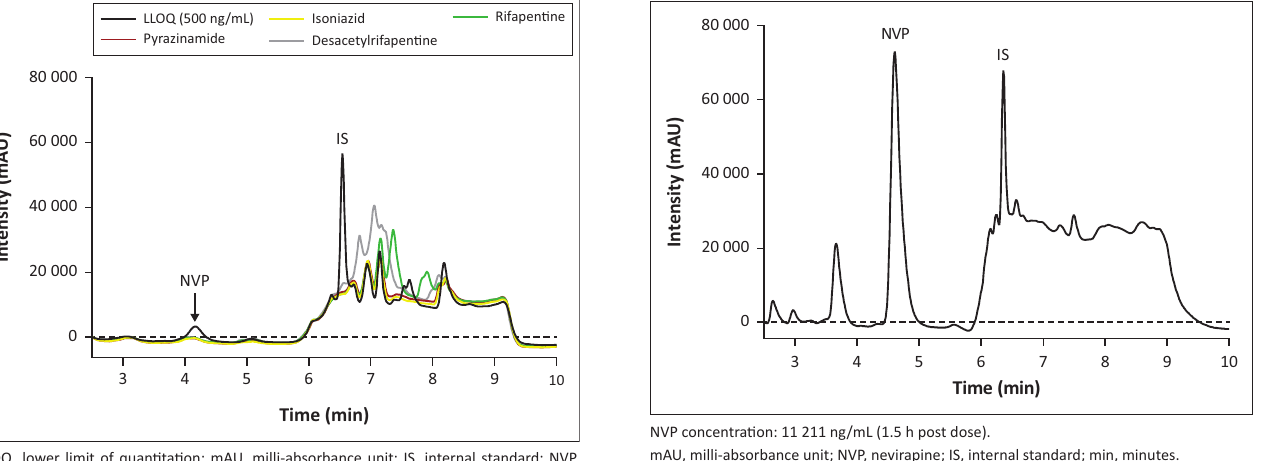
FIGURE 6: Chromatogram of patient sample. (Samples collected at Parirenyatwa Opportunistic infections clinic in 2013 and assayed at University of Zimbabwe International Pharmacology